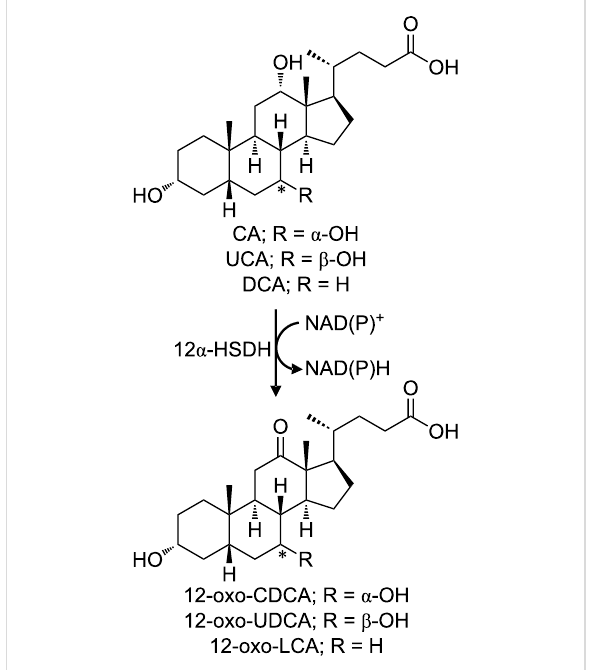
Figure 4: Reaction catalysed by the 12 α -HSDH; the 12-OH group of CA or UCA is oxidized yielding 12-oxo-CDCA or 12-oxo-UDCA, re- spectively, with the concomitant reduction of one molecule of NAD(P) +